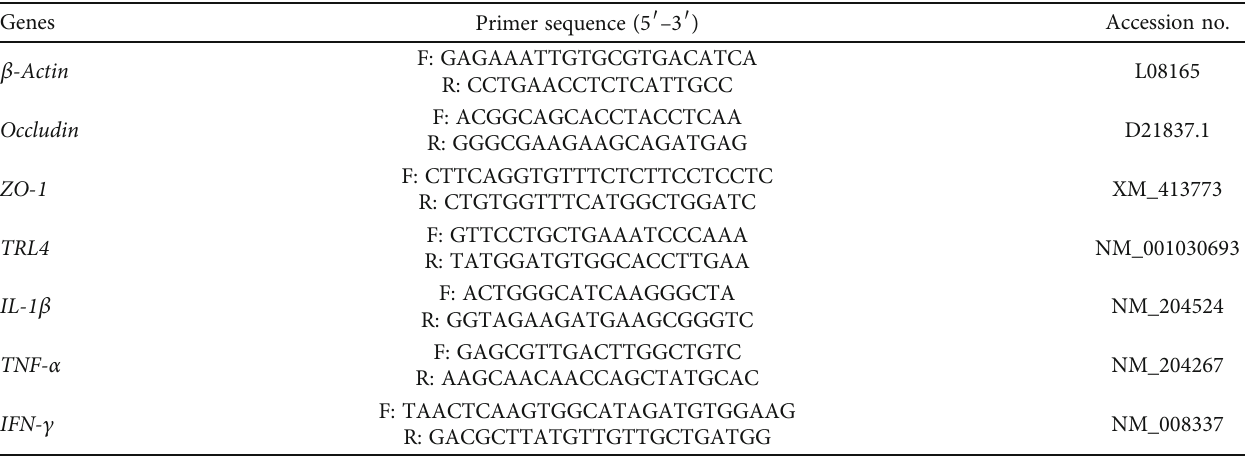
Table 2: Sequences for real-time PCR